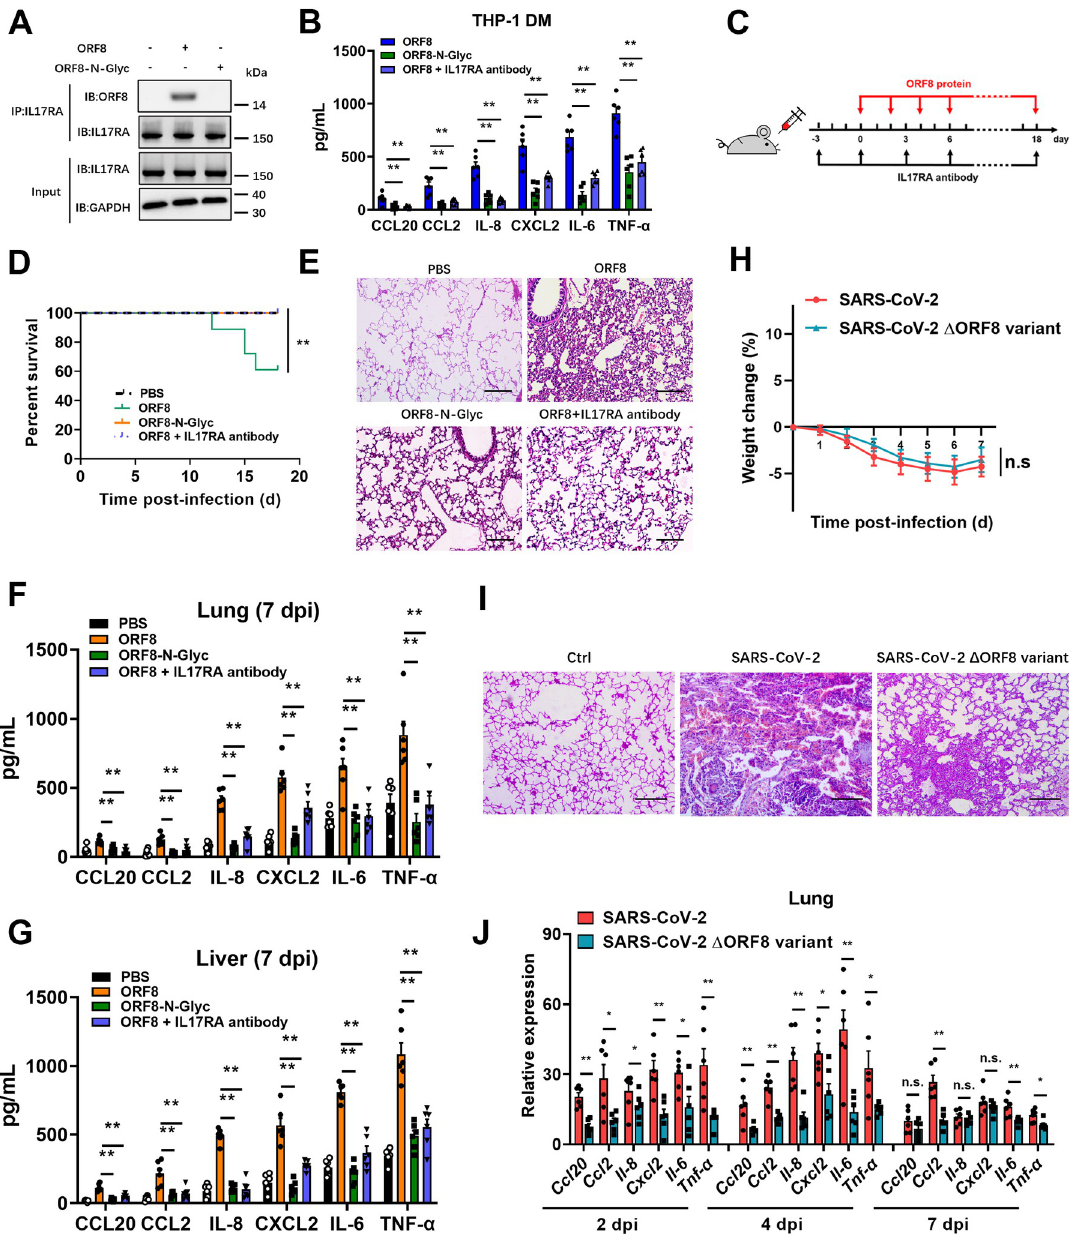
Fig 5. N-linked glycosylation of ORF8 protects mice from cytokine storm. (A) Unglycosylated ORF8 (ORF8) or synthetic N-linked- glycosylated ORF8 (ORF8-N-Glyc) (1 μ g/mL) was added into the culture medium of THP-1 DM cells to stimulate IL-17 pathway. The interaction of ORF8 and IL17RA was detected by co-immunoprecipitation. (B) ORF8 or ORF8-N-Glyc protein was added into the culture medium of THP-1 DM cells at a concentration of 10 ng/mL. The release of cytokines and chemokines was detected by ELISA. (C) Schematic diagram of ORF8 protein treatment model. Mice were treated with aerosols of PBS (n = 13), unglycosylated ORF8 (n = 18) or synthetic N-linked-glycosylated ORF8 proteins (n = 17) (200 μ g/mouse) every other day. For IL17RA antibody injections (n = 12), each mouse received 200 μ g per injection every three days as indicated. (D-G) Survival curves were calculated using the Kaplan-Meier method (D). Lung lesions were detected by H&E staining at day 7 post infection (dpi) (E). The release of cytokines and chemokines in lungs (F) and livers (G) were detected by ELISA at 7 dpi. (H-J) Hamsters were intranasally infected with 4 × 10 5 PFU SARS-CoV-2 (n = 18) or ORF8-deleted SARS-CoV-2 variant (n = 18). Weight loss data were documented daily (H). Lung lesions were detected by H&E staining at 7 dpi (I). The relative expression of cytokines and chemokines in lungs were detected by qRT-PCR at 2, 4 and 7 dpi (J). Representative images from n = 3 biological replicates are shown (A, E, I). Data are shown as the mean ± s.e.m. of n = 6 biological replicates (B, F, G, J). Log-rank (Mantel-Cox) test (D) and one-way ANOVA followed by Bonferroni post hoc test (B, F, G, J) were used for data analysis. Scale bar = 500 μ m. � , p < 0.05, �� , p < 0.01. Abbreviations: n.s., not significant.